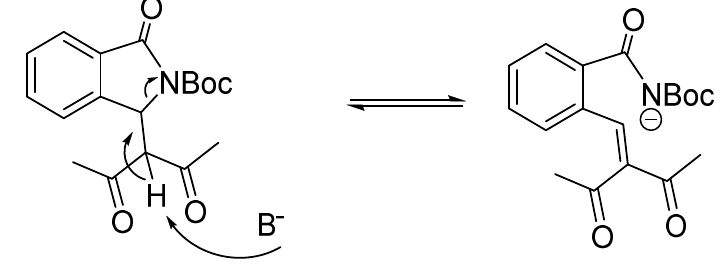
Figure 3. Proposed TS for catalyst-mediated cyclization. All these experiments point out that racemization may occur on the cyclic product, probably via a retro aza-Michael reaction under basic conditions, as depicted in Scheme 1. Removing the acidic proton of acetylacetone moiety should prevent racemization.